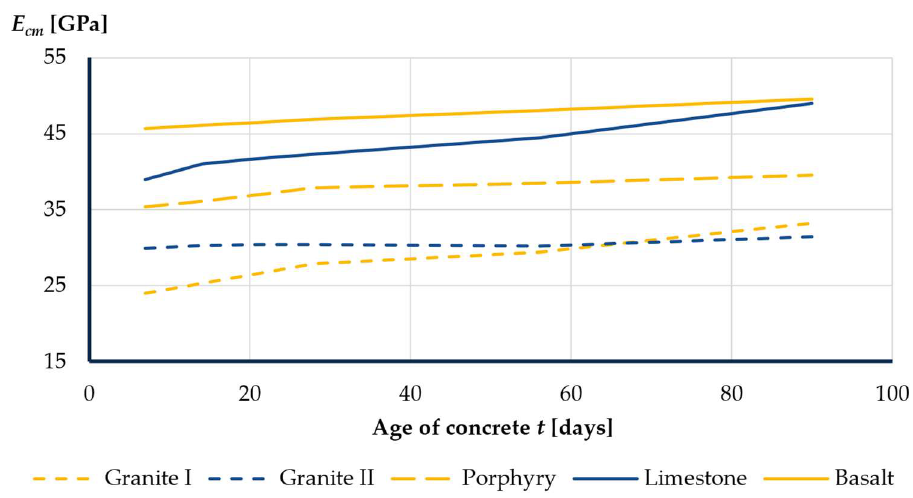
Figure 1. The modulus of elasticity of concrete with the use of various aggregates over time.